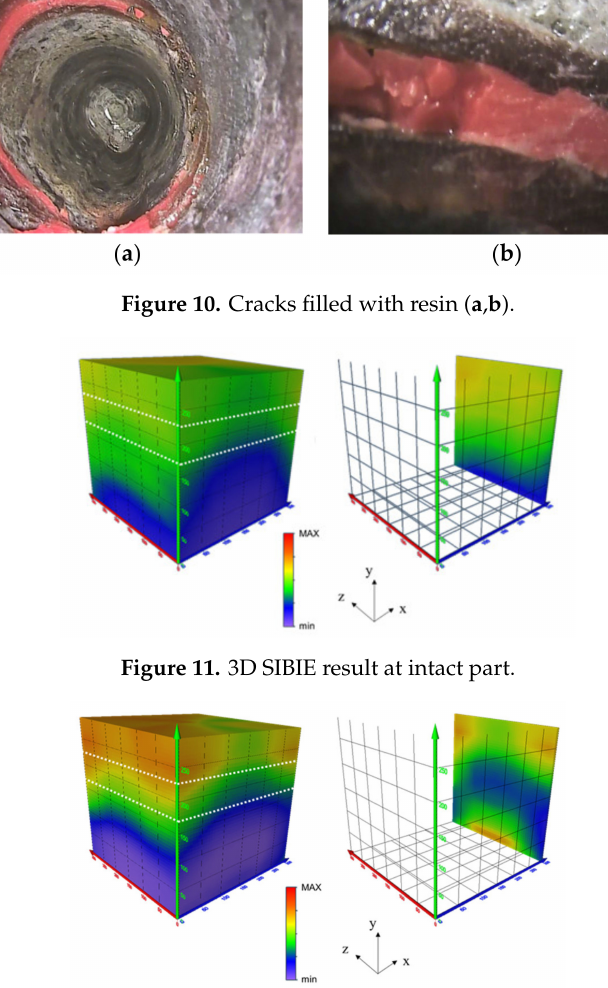
Figure 12. 3D SIBIE result at damaged